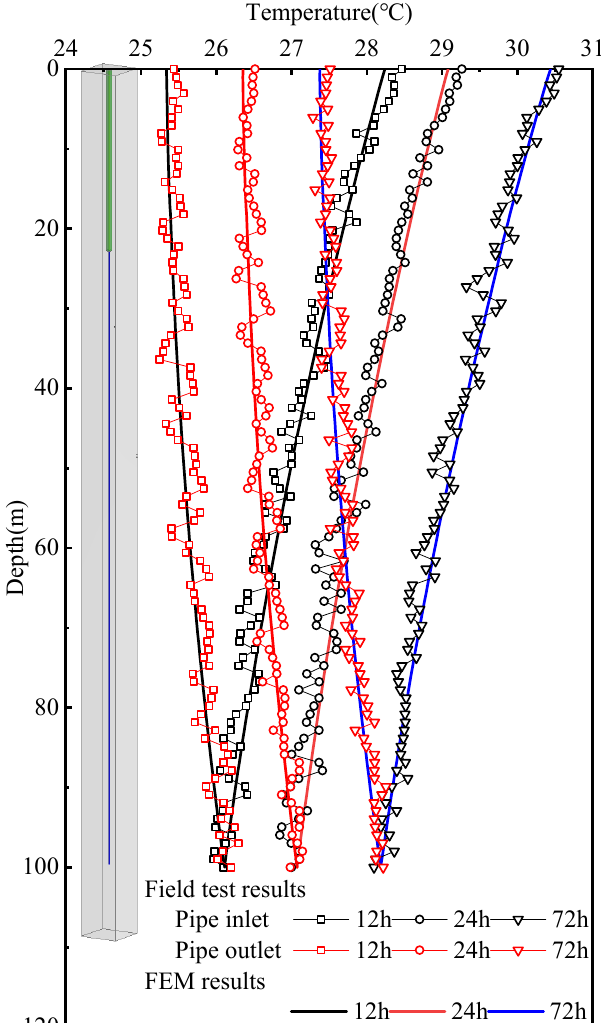
Figure 5. The temperature distribution law of the heat-exchange pipe along the depth direction. To estimate the deviations between the field experiment and the results of the numerical simulation, Python software was used to calculate the value of RMSE (named root-mean- squared error). This indicated that the value of RMSE is 0.144 after 12 h of the heating exchange operation. After 24 and 72 h of the heating exchange operation, the values of RMSE are 0.138 and 0.112, respectively. This shows that the result of the numerical simulation is consistent with the field measured data, and all values of the RMSE are much lower than